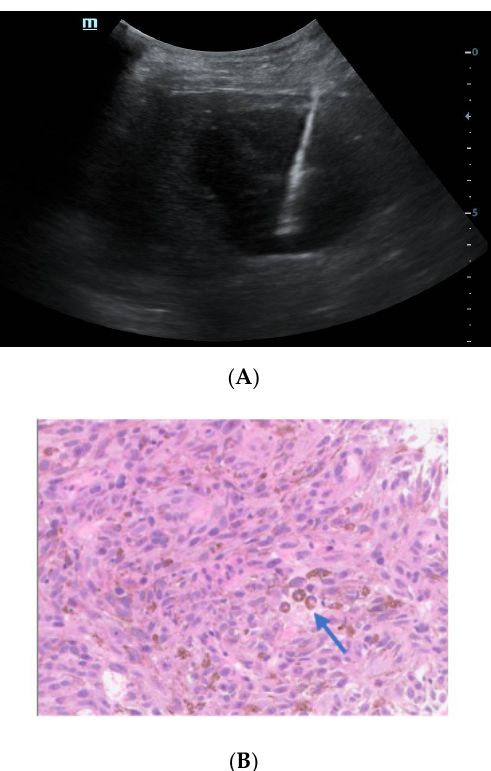
Figure 4. Ultrasound-guided percutaneous coarse needle biopsy (US-CNB) was carried out to acquire